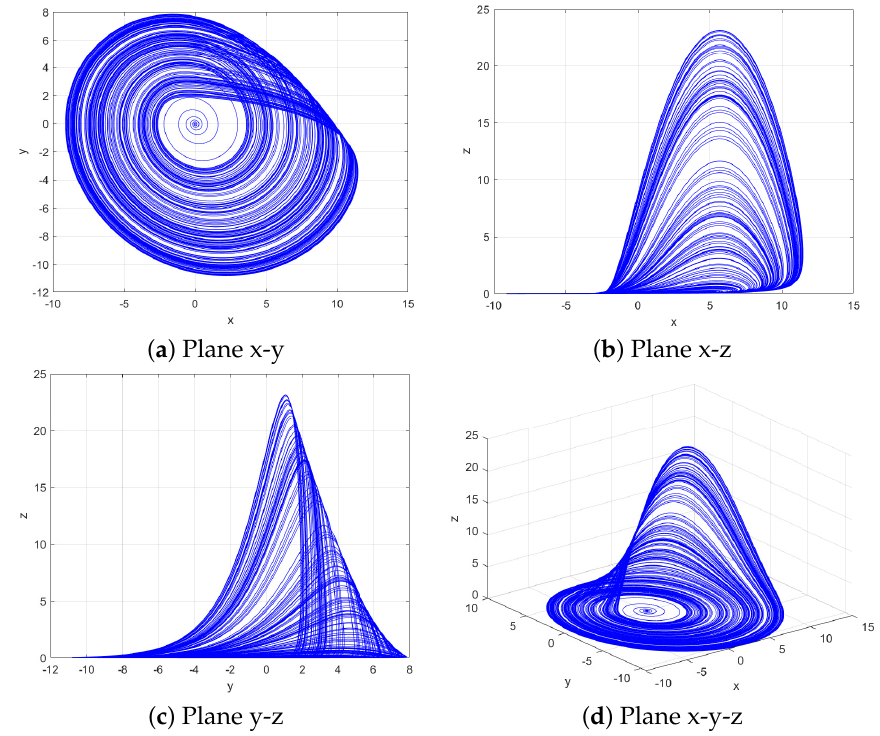
Figure 2. Phase-space portraits of the Rössler chaotic system given in